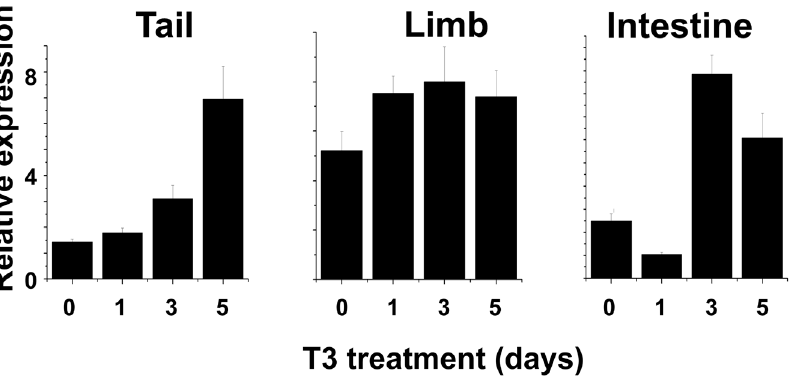
Figure 4. T3 up-regulates LGR5 expression in premetamorphic tadpoles. Tadpoles at stage 54 were exposed to 5 nM T3 for 0–5 days before tissue isolation, RNA extraction, and qRT-PCR analyses as in Fig. 3C.